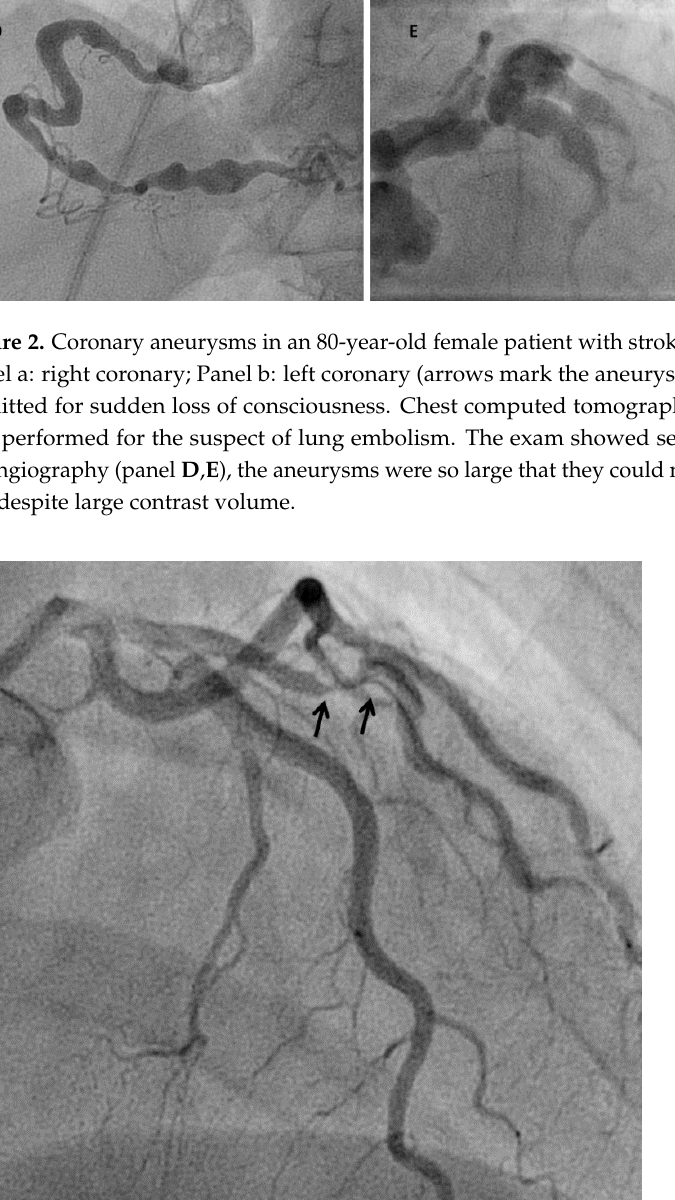
Figure 4. Coronary spasm in a 51-year-old female patient with ANCA-associated vasculitis and spasm of the proximal left anterior descending (panel a ) causing a Tako-Tsubo-like contractile dysfunction ( b , c ). Coronary angiography does not detect inflammation, necrosis or reactive thickening of the arterial wall. Non-invasive assessment of the cardiac and extracardiac circulation using computed tomography or magnetic resonance imaging is therefore recommended in patients with large (giant cell arteritis and Takayasu ’ s arteritis), medium (poliarteritis nodosa) or variable (Behçet ’ s disease) vessel vasculitis. Patients with small vessel vascu- litis (i.e., ANCA-associated) often have associated myo- or pericarditis, which should also be investigated using magnetic resonance imaging. Periarterial soft tissue thickening or